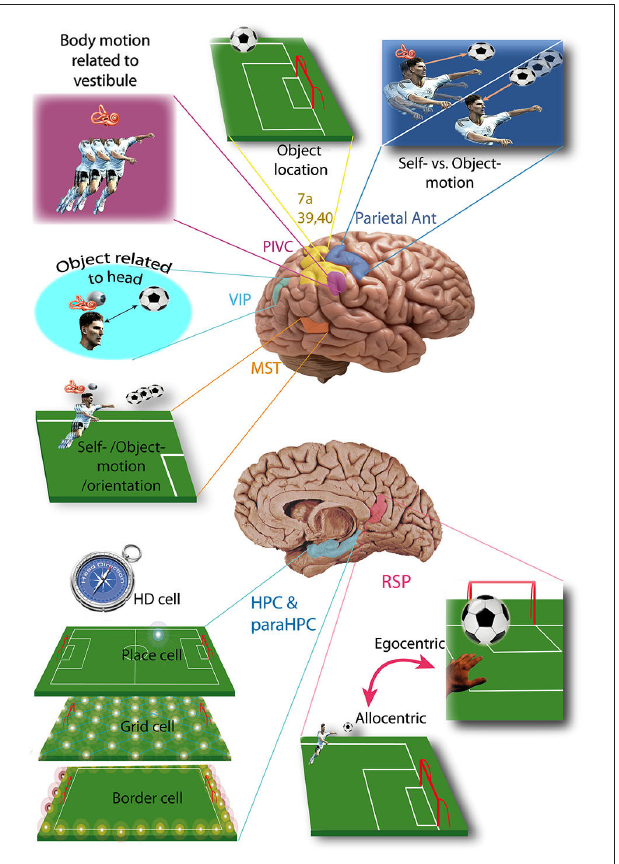
FIGURE 1 | Vestibular cortices and spatial cognition . Vestibular cortices involved in spatial cognition, illustrated in a soccer player: HD cell, head direction cell; HPC, hippocampus; MST, medial superior temporal area; ParaHPC, parahippocampal cortex; Parietal Ant, parietal anterior cortex; PIVC, parieto-insular vestibular cortex; RSP, retrosplenial cortex; VIP, ventral intraparietal area; 7a, 39, 40 Brodmann area. (References in the